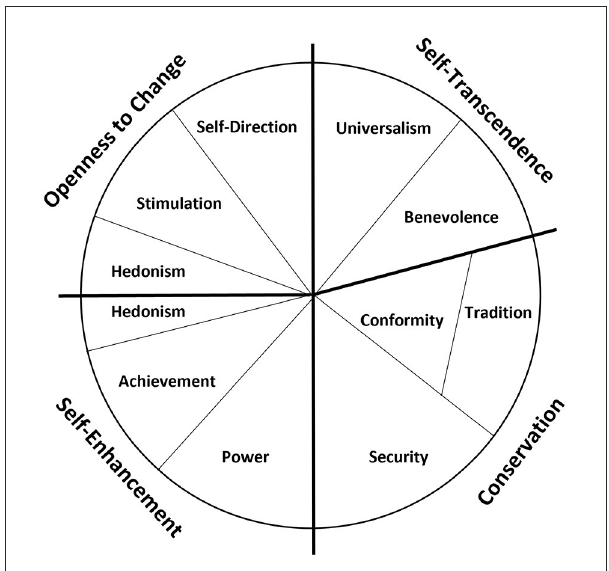
FIGURE1 Theoretical model of relationships between the ten motivation types of held value [obtained from Schwartz (29). CC BY-SA 4.0]. The more distant the two values on the continuum, the more antagonistic their motivations. Tradition and conformity are located in a single wedge as they share the same broad motivational goal; the absolute nature of tradition values demanding a stronger rejection of opposing values. Solid lines denote the value’s relationship with the respective motivational